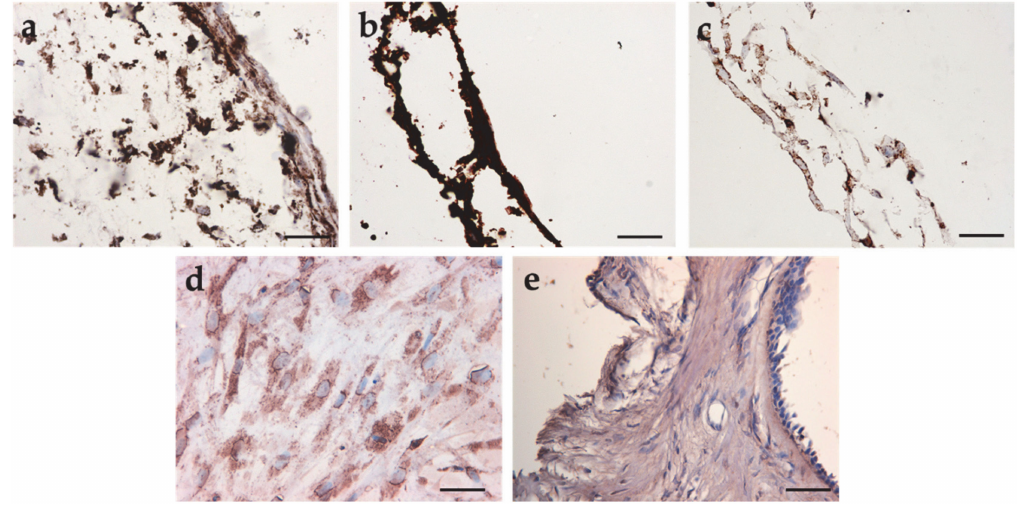
Figure 4. Immunohistochemical analysis of hMSC / *PCL constructs showing fibroblast surface marker expression in brown and cell nuclei in violet as obtained via immunohistochemistry on: ( a – c ) hMSC / *PCL constructs [( a ) statically di ff erentiated, ( b ) dynamically di ff erentiated, ( c ) undi ff erentiated]; ( d ) undi ff erentiated hMSCs cultured on chamber slides; ( e ) human TMs. ( a – e ) Scale bar is 50 µ m. Original magnification 400 ×